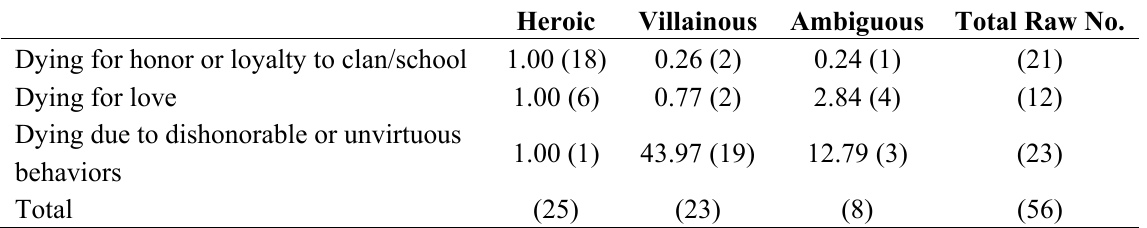
Table 4. The normalized index indicating the reasons for nuxia characters’ deaths. Heroic Total Raw